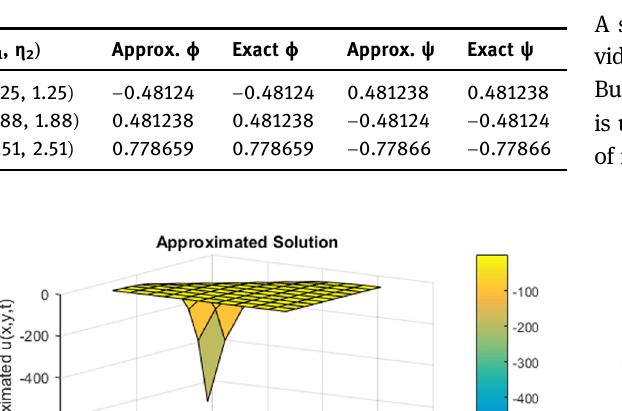
Table 8: Comparison of approximate and exact results at di ff erent mesh points regarding Example 3